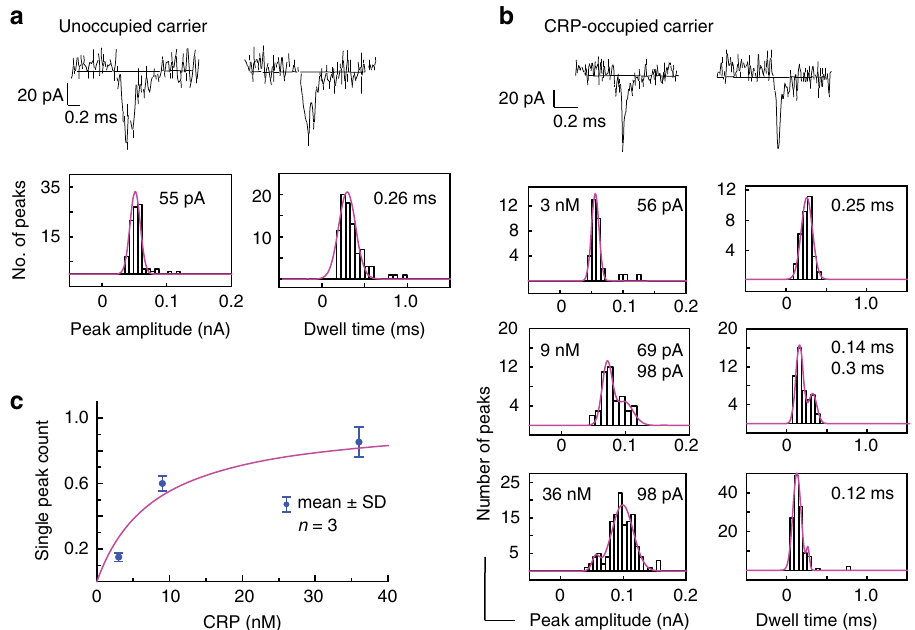
Fig. 4 CRP detection in diluted human plasma. Typical ion current traces, and peak amplitude and dwell time histograms for a unoccupied carriers and b CRP-occupied carriers incubated in different concentrations of CRP in 5% plasma. c Normalised single peak count, i.e., ratio of single peaks vs total classi fi ed peaks against CRP concentration (Supplementary Tables 3 and 4). The solid line is a guide to the eye. The error bars are standard deviation calculated from three different traces ( n = 3). The sampling time was 2 min for all samples. Source data are in the Source Data fi